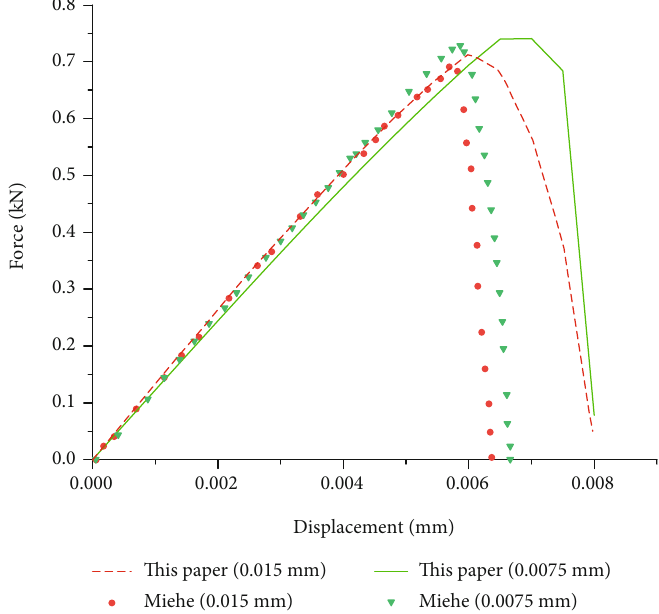
Figure 6: Comparison of load-displacement curves of di ff erent l .